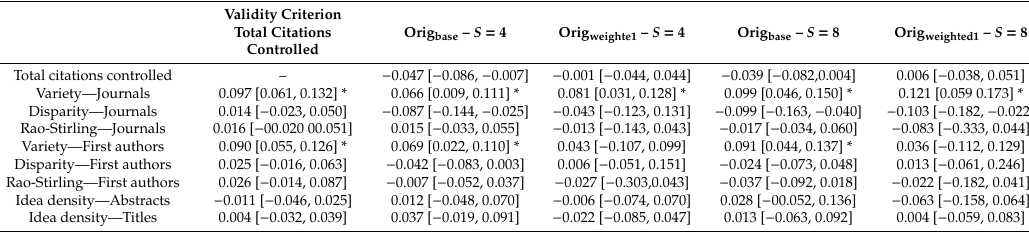
Table 3. Validity findings for the bibliometric dataset.